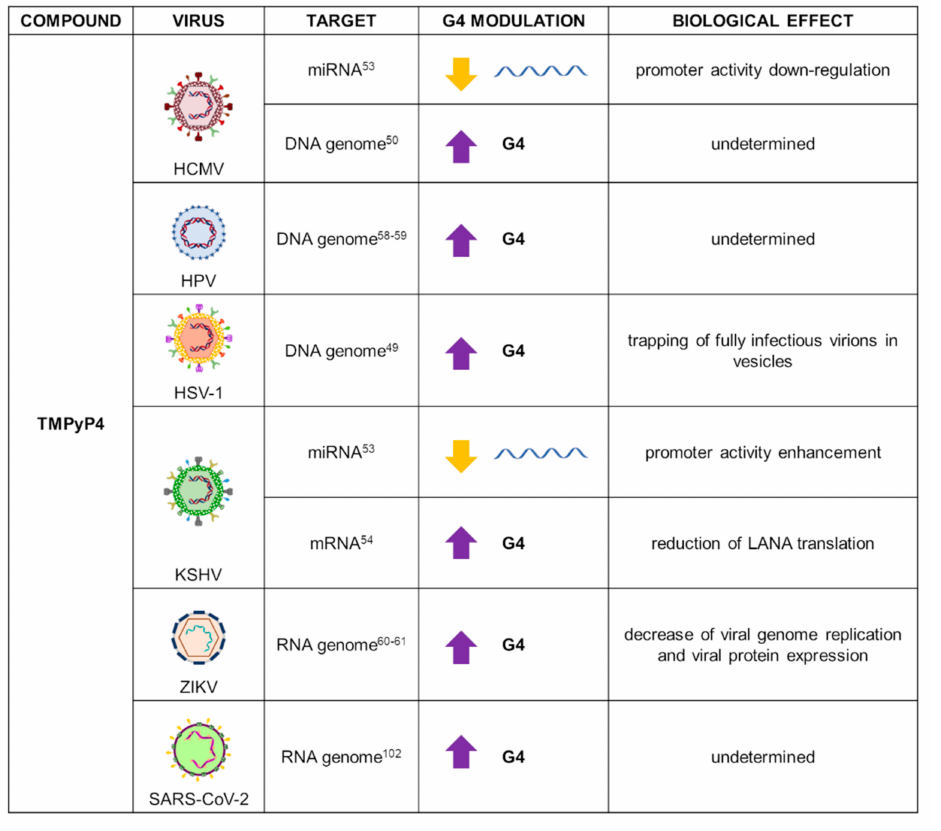
Figure 3. Summary of TMPyP4 applications as a G4 ligand in virology. For each target virus, the site of action (also known as the G4 location), the modulatory effect on G4s, and the overall biological outcome are